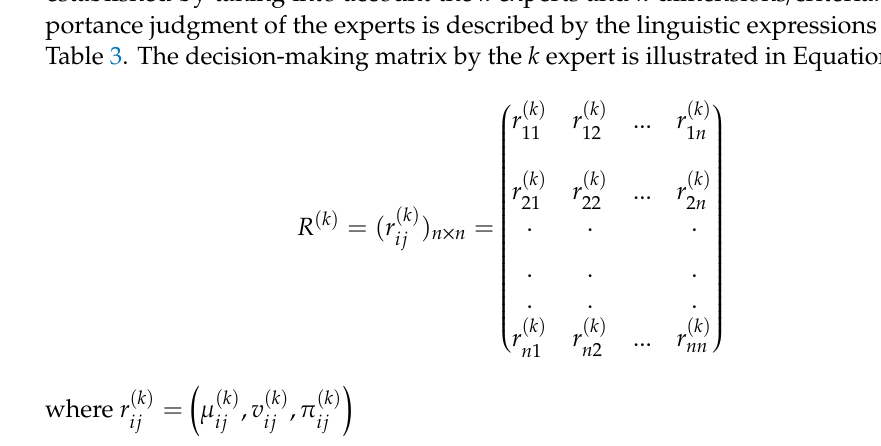
Table 3. The decision-making matrix by the k expert is illustrated in Equation (15):